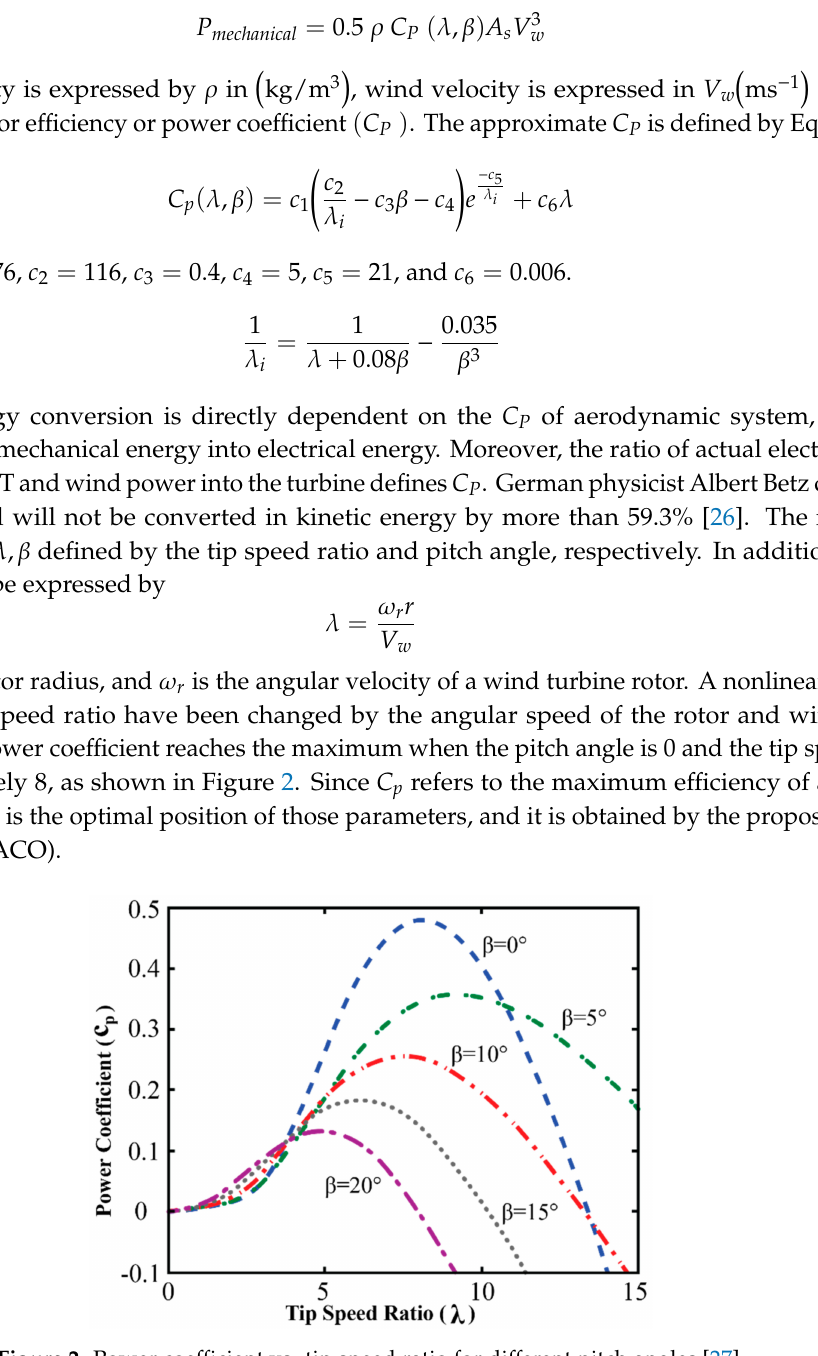
Figure 2. Power coe ffi cient vs. tip speed ratio for di ff erent pitch angles